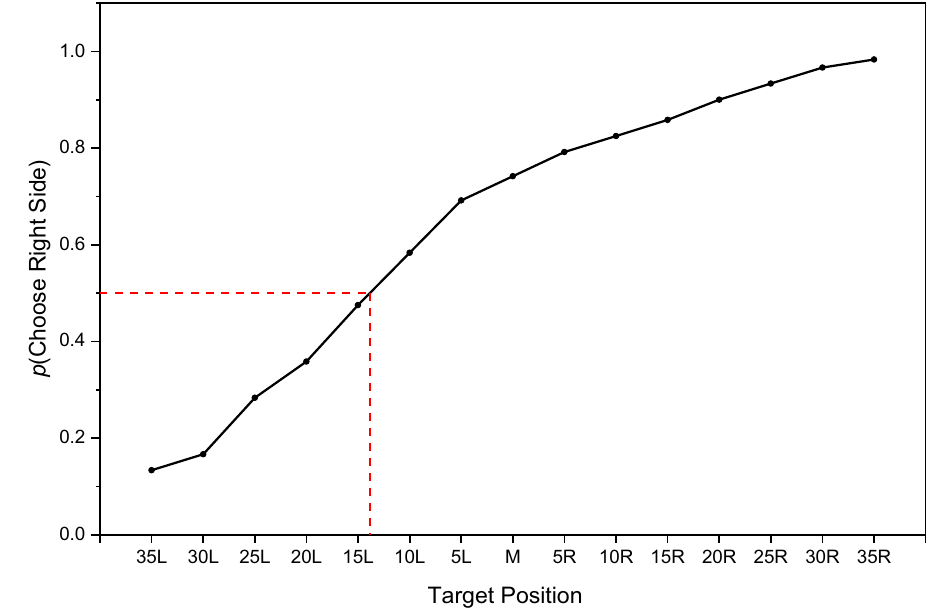
Figure 9. Probability of choosing to the right side of the obstacle as a function of target location when the target was changed by 5 cm successively to the left side or to the right side. M indicates target in the middle, L indicates a shift of the target to the left side and R indicates a shift of the target to the right side. The dashed line shows 50% probability of selecting the right side of the